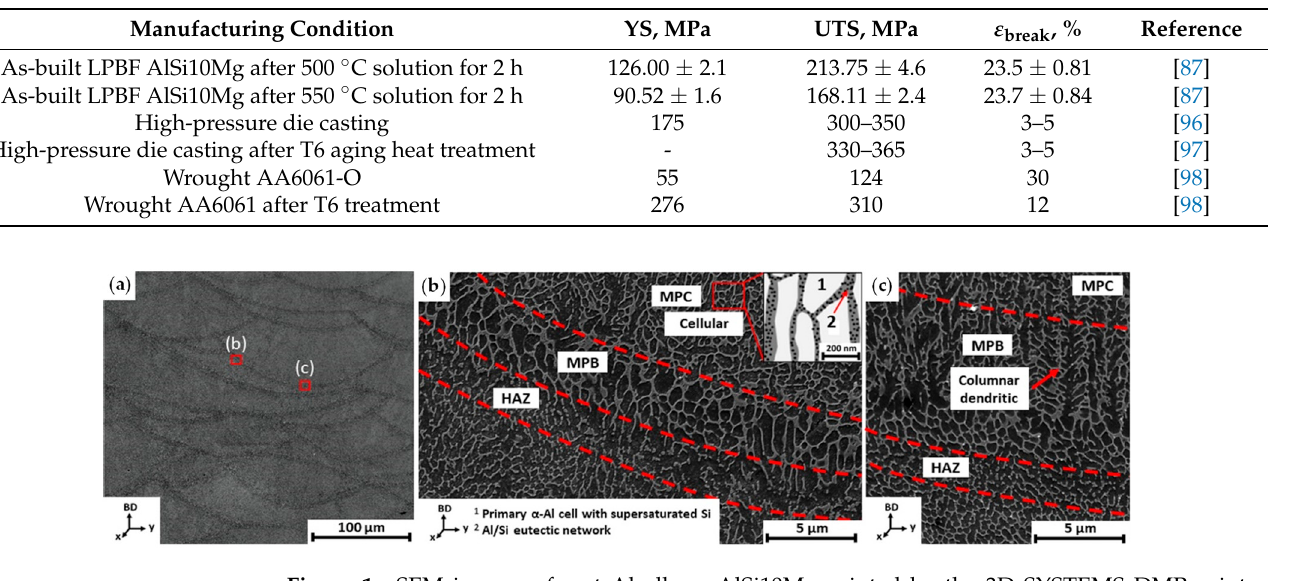
Figure 3. Microstructure of the LPBF ‐ fabricated AA6061: ( a ) XY plane (perpendicular to build di ‐ rection); ( b ) ZX plane (build direction). Reproduced with permission from Elsevier [38]. 3. Challenges in AM of HS ‐ Al Alloys Challenges regarding the poor printability of HS ‐ Al alloys are primarily related to the formed metallurgical defects, including cracking, porosity, oxidation, element vapor ‐ ization, balling, and satellite generation, among which cracking and porosity are most disastrous. The underlying reasons associated with the cracking in AM of high ‐ strength Al alloys are majorly attributed to the elongated grain structure, large freezing range, high coefficient of thermal expansion, and oxide film [100–102]. Differently, the presence of moisture is the primary reason behind porosity in Al alloys due to Al affinity towards oxygen [103]. This review paper will focus on the dominant defects—cracking and poros ‐ ity—in AM of HS ‐ Al alloys. Concerning the common defects in metal AM processes, such as residual stresses, non ‐ equilibrium microstructure, and anisotropy, please refer to Ref. [58,59,62]. 3.1. Cracking Hot cracking or solidification cracking is common in AM ‐ processed HS ‐ Al alloys. For example, Zhang et al. [104] reported long cracks along grain boundaries of large columnar grains towards the build direction in the LPBF ‐ fabricated Al ‐ Cu ‐ Mg alloy. A similar crack morphology was also observed in the LPBF of 7075 [30]. The primary factors leading to hot cracks in AM of HS ‐ Al alloys are summarized in Figure 4.